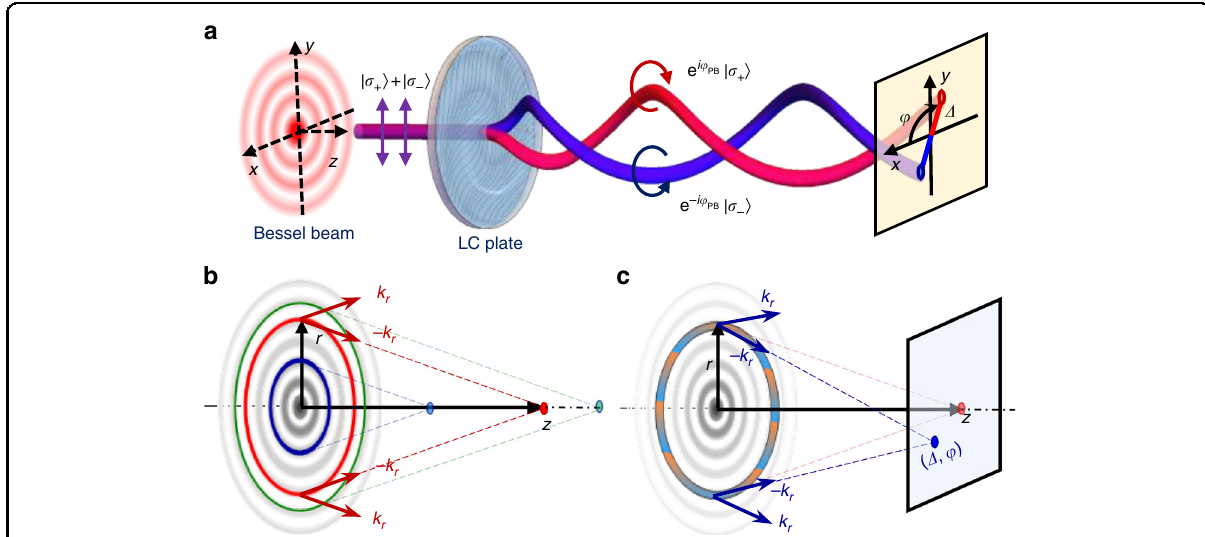
Fig. 1 Schematic of oscillated photonic spin Hall effect (PSHE). a A linearly polarized Bessel beam passes through a Pancharatnam-Berry phase optical element (PBOE), and splits into two intertwined spin states. b Schematic of the transverse-to-longitudinal mapping. c Beam deviation under an oblique-phase modulation of a Bessel